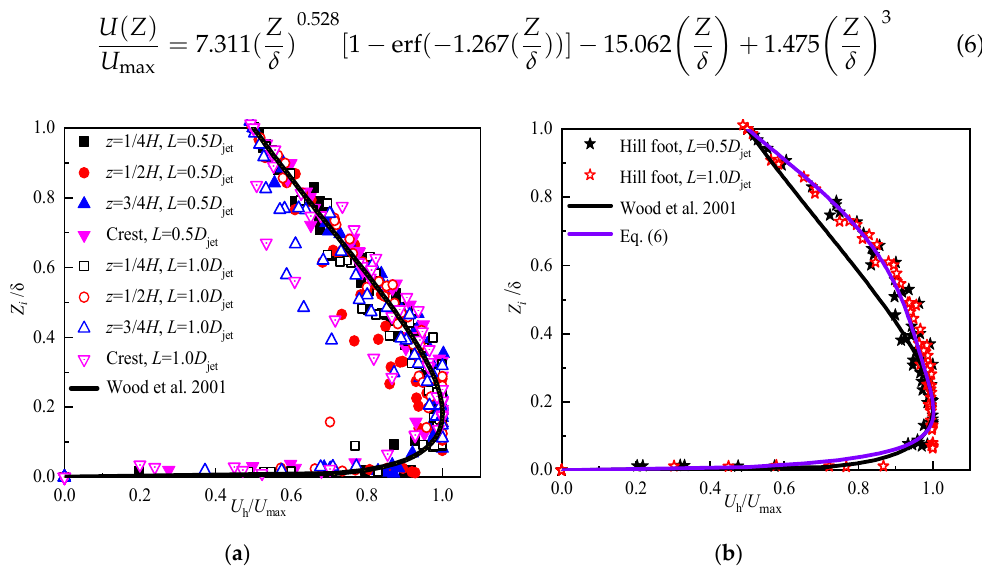
Figure 25. Normalized envelope values of horizontal wind velocity: ( a ) on hill; ( b ) hill foot.